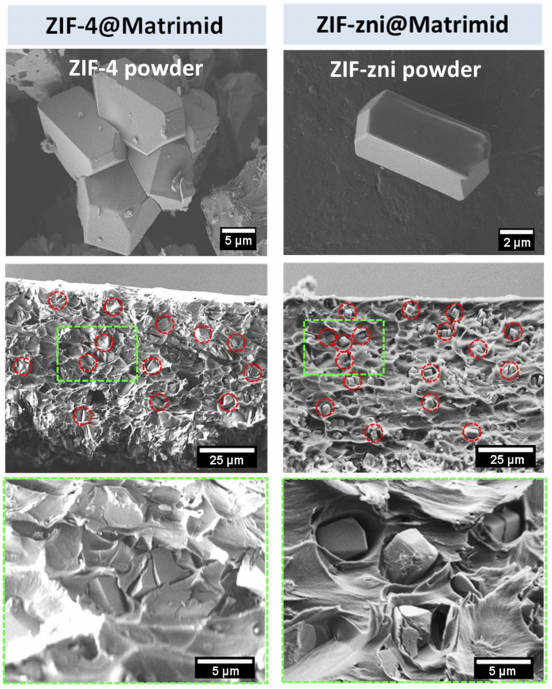
Figure 5. SEM pictures of exemplary MMMs with 10 wt % ZIF-4 ( left ) and ZIF-zni ( right ). Top images show the used powder materials for MMM preparation. Both pictures in the middle are cross sections of the above-mentioned MMMs, which indicate homogeneous distributed filler particles (red circles). Green squares display enlarged areas, shown at the